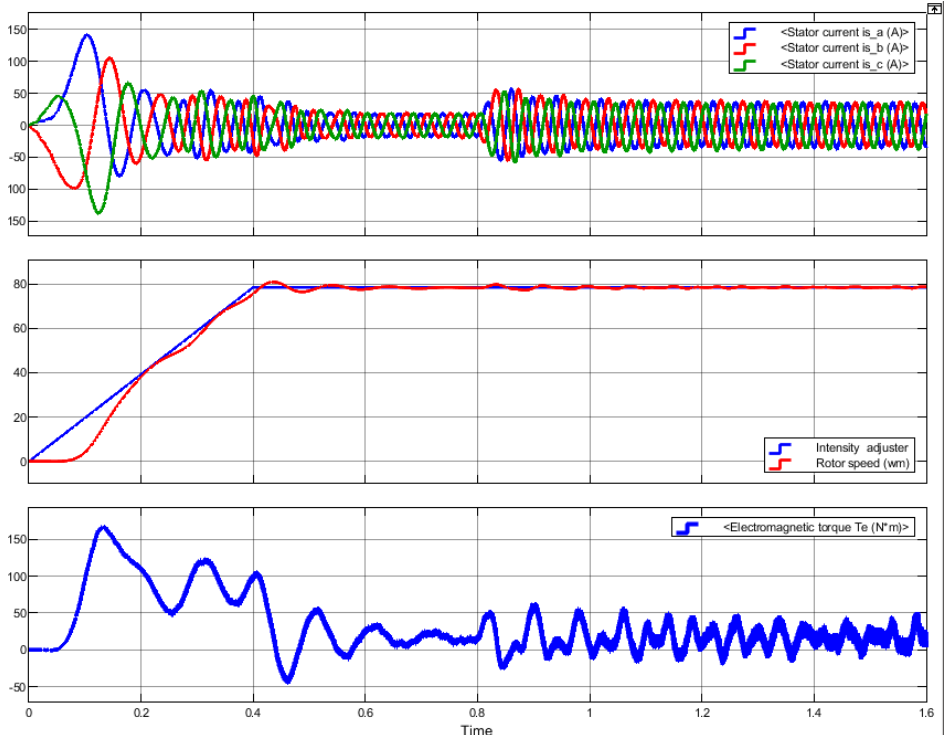
Figure 9. Oscillograms of output coordinates of the electric motor when simulating a short circuit in phase A-B at the time t = 0.8 s in the steady state.